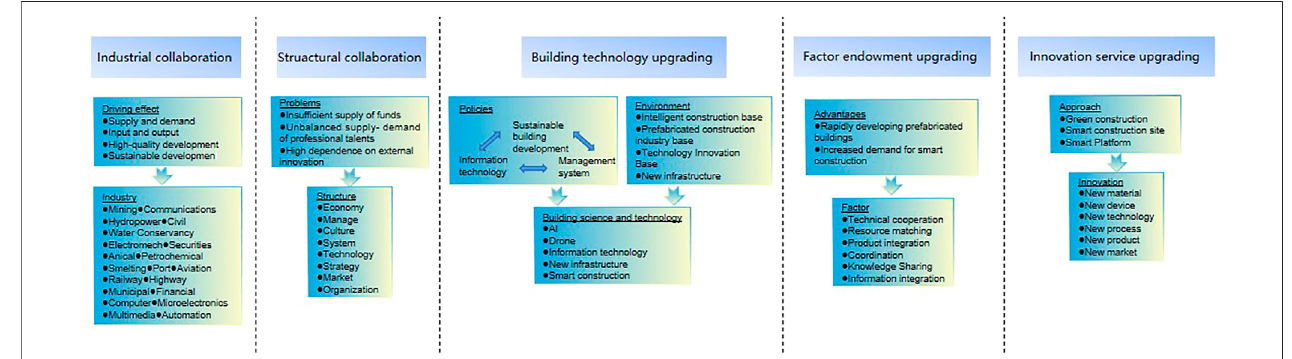
FIGURE 3 | Collaborative Paths in the collaborative development of